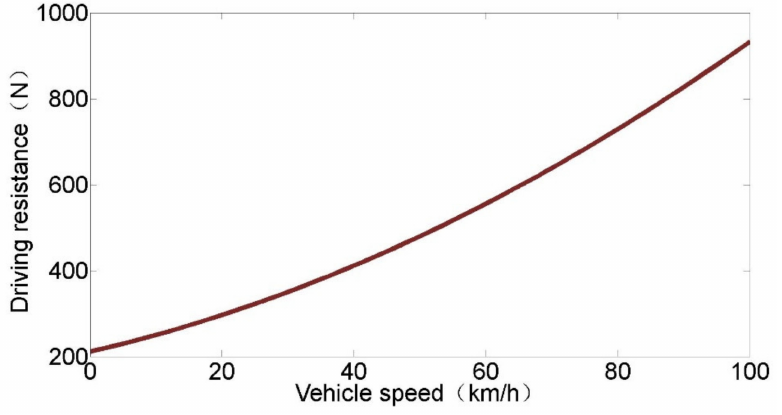
Figure 7. Vehicle driving